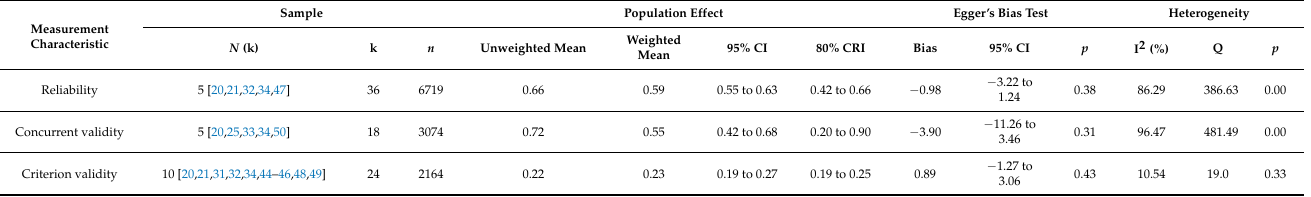
Table 5. Summary results for test–retest reliability, concurrent validity and criterion validity across all included studies. Measurement